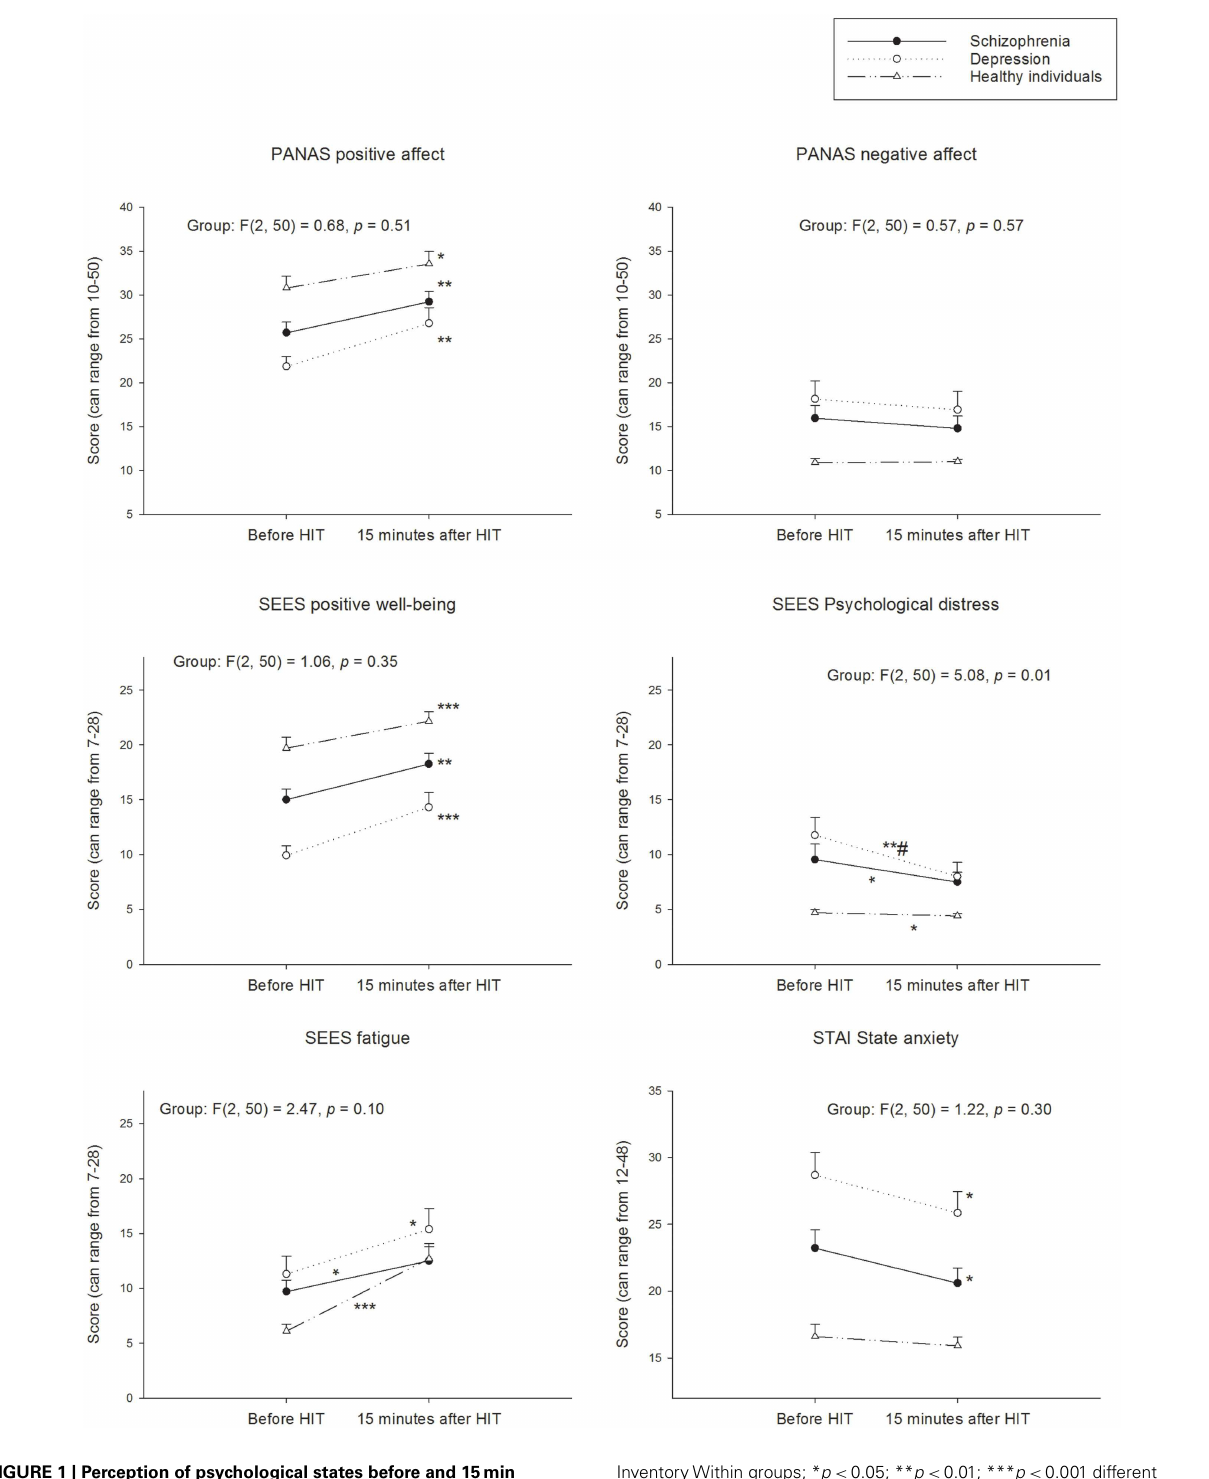
InventoryWithin groups; * p < 0.05; ** p < 0.01; *** p < 0.001 different from before HIT. Between groups; different change from healthy # p <